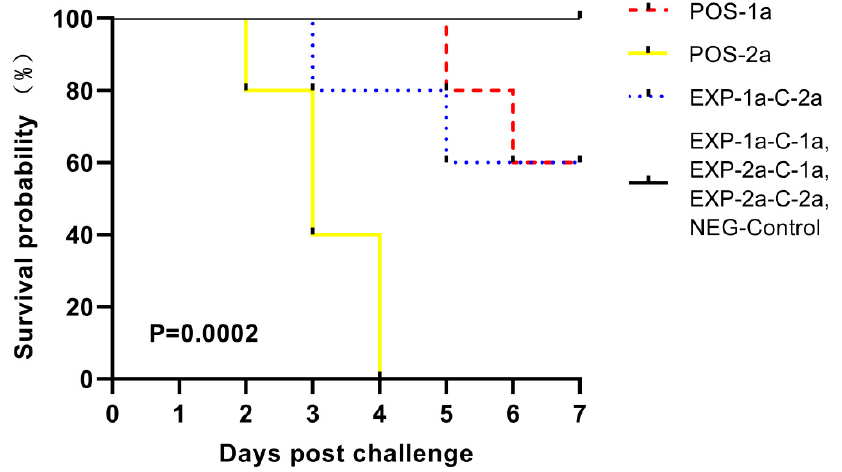
Figure 7. Kaplan–Meier curves for mortality of piglets orally challenged by CV777 or CH/JX/01.